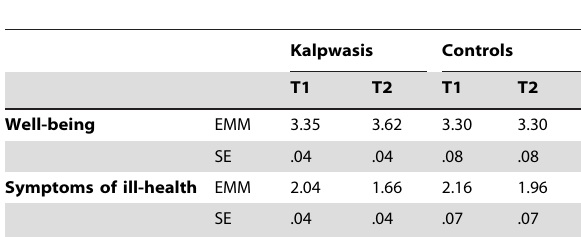
Table 1. Well-being and Symptoms of Ill-health amongst Kalpwasis and Controls at T1 and T2.